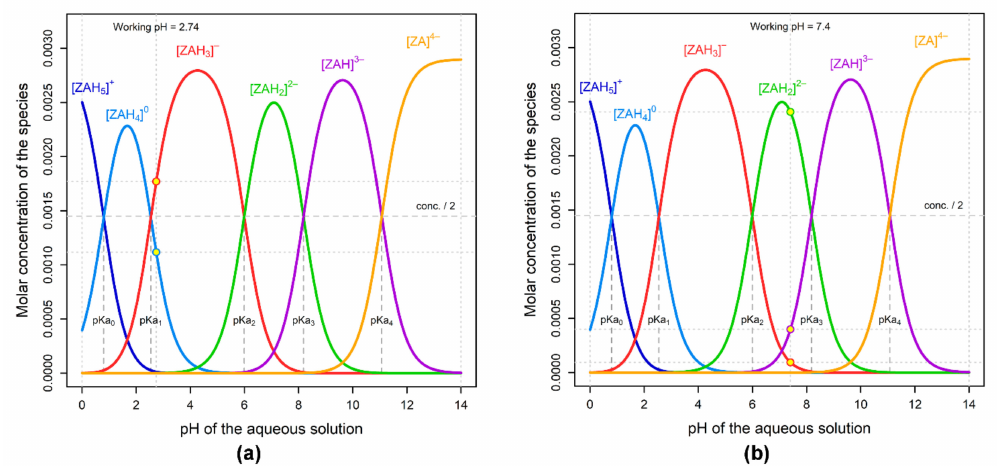
Figure 2. ZA speciation as a function of pH in the commercial aqueous solution of 0.0029 M (4 mg/ 5 mL, Actavis Group): ( a ) Working pH = 2.74; ( b ) Working pH = 7.4.